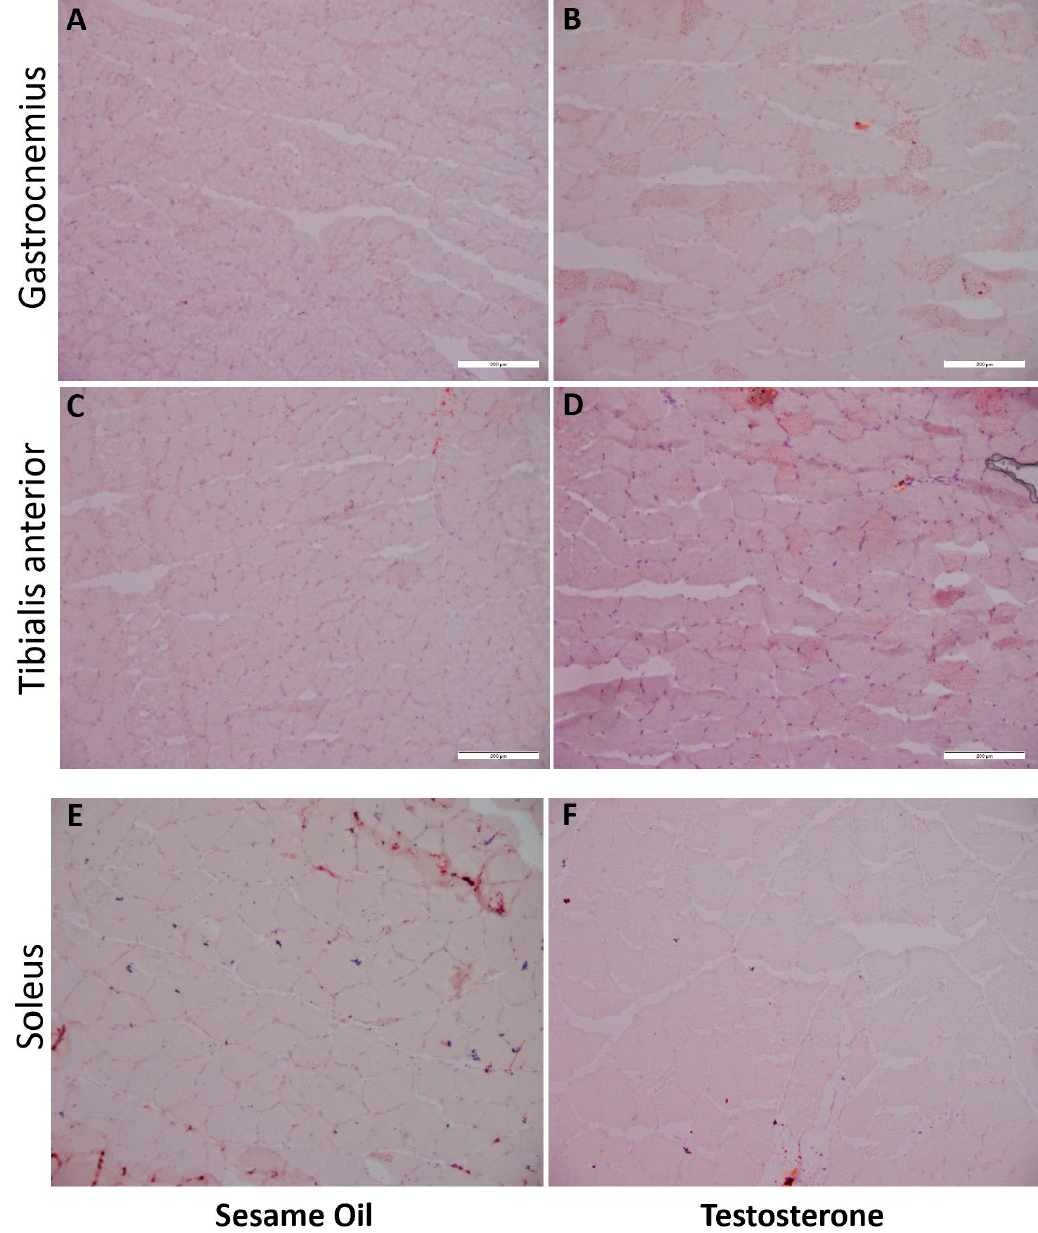
Figure 7. More Oil Red O staining of lipids in gastrocnemius and tibialis anterior muscles from PNA rats. Gastrocnemius, tibialis anterior, and soleus muscles from 16-week-old rats prenatally exposed to sesame oil ( n = 8) or testosterone ( n = 8) were snap-frozen and cryosectioned at 10 µm thickness prior to fixing in paraformaldehyde and staining for lipids with Oil Red O (ORO). Scale bars, 200 µm. For each rat, 2–4 distinct fields per muscle sample were imaged at 200× magnification; representative images from muscles from rats prenatally exposed to sesame oil ( A , C , E ) or testosterone ( B , D , F ) are shown. More prominent intra-muscular and peri-muscular staining with ORO was noted in the GN and TA muscles from PNA rats. No difference was appreciated between control and PNA rats in soleus muscles.